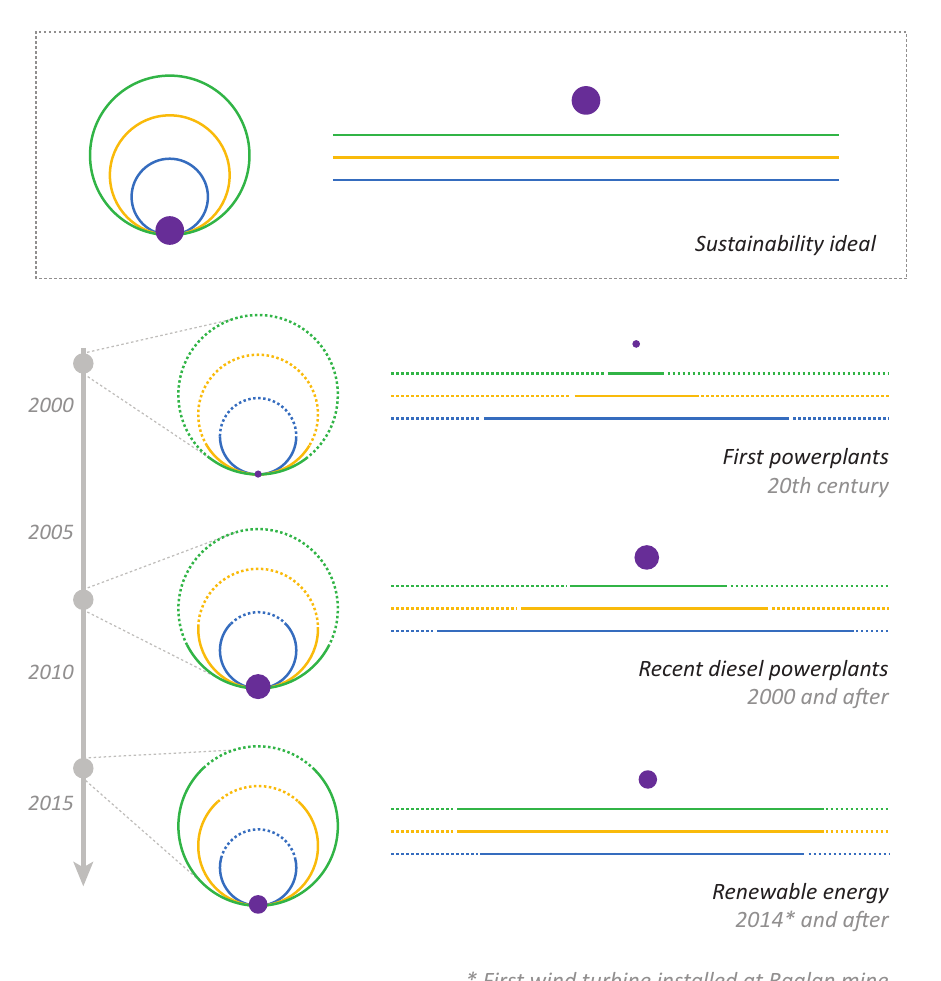
Figure 6. Evolution of durability and procedural equity for energy production projects in Nunavik. The top depiction shows an ideal scenario with total sustainability and equity. The following depictions show the categories of sustainability through time as they relate to different technologies and sources of energy.